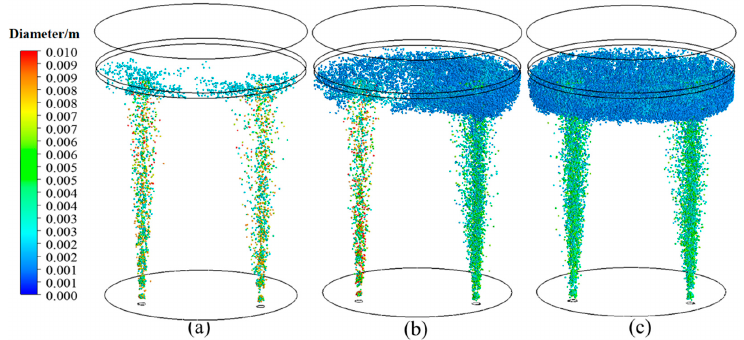
Figure 10. Bubble distribution with different bottom stirring mode: ( a ) S-S mode, ( b ) S-P mode, and ( c ) P-P mode.